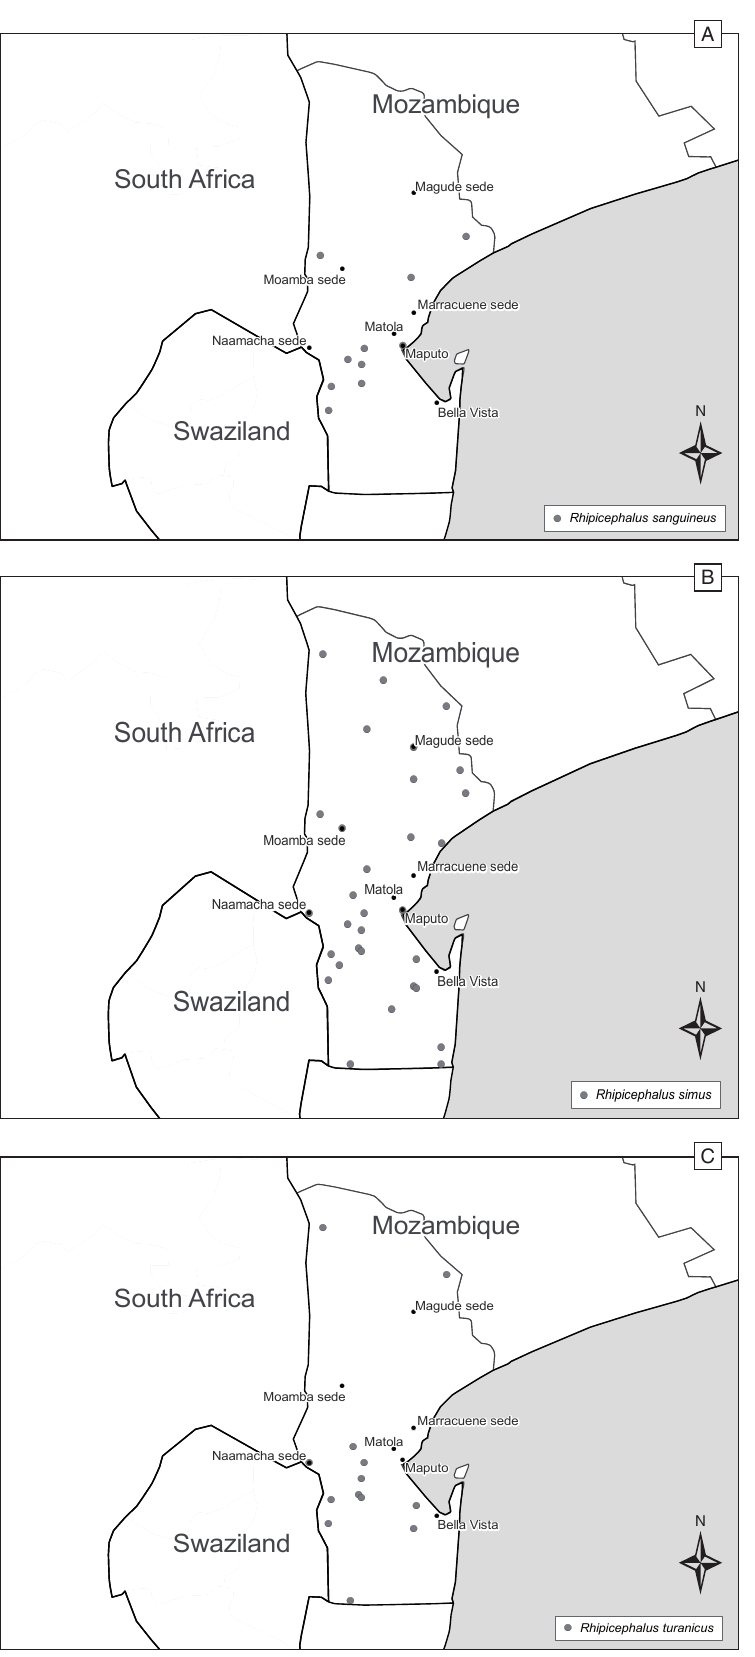
Geographic distribution of (A) Rhipi cephalus sanguineus , (B) Rhipiceph alus simus , and (C) Rhipi ceph alus tura nicus in Maputo Prov- ince, Mo zam